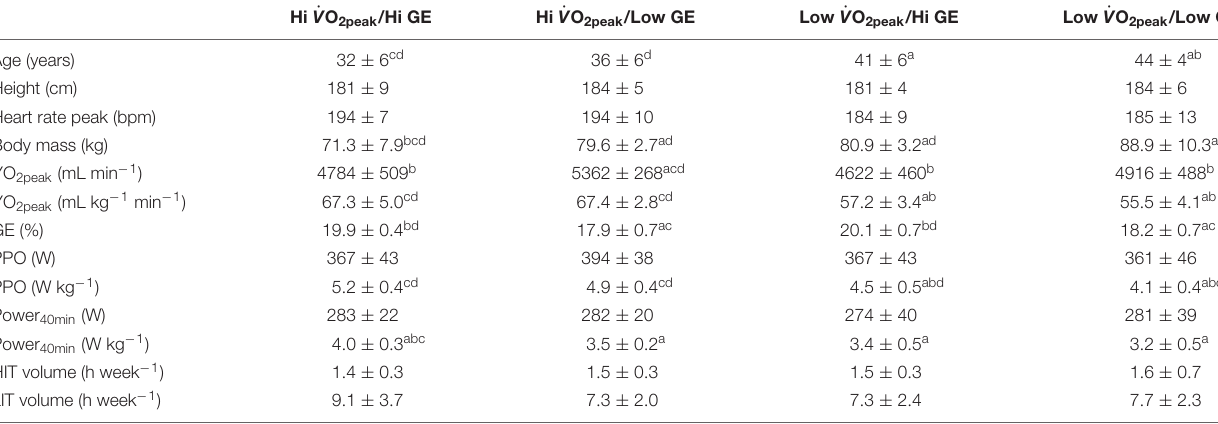
TABLE 2 | Pre-test characteristics and training data during the 12-week intervention period for the four